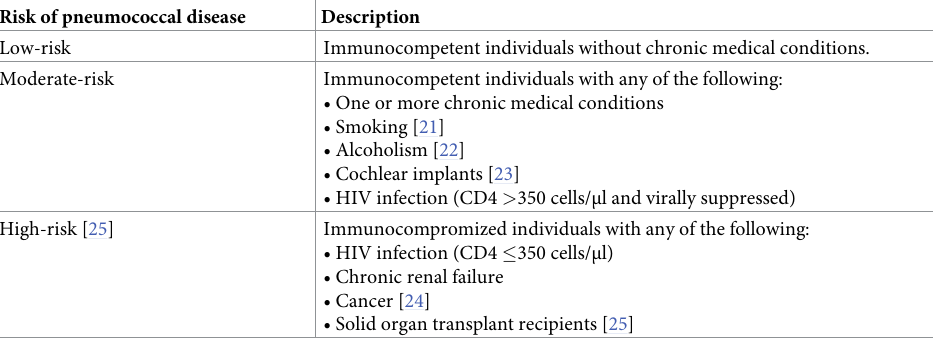
Table 1. Risk categories for pneumococcal